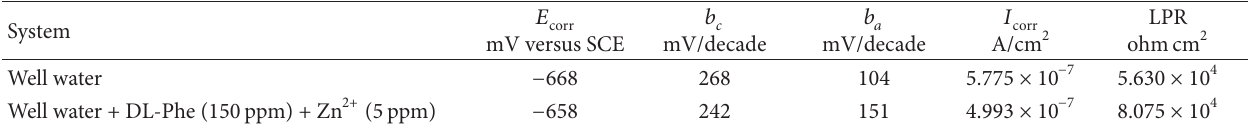
T 5: Corrosion parameters of carbon steel immersed in well water in the absence and presence of inhibitor system obtained from potentiodynamic polarization study (pH =